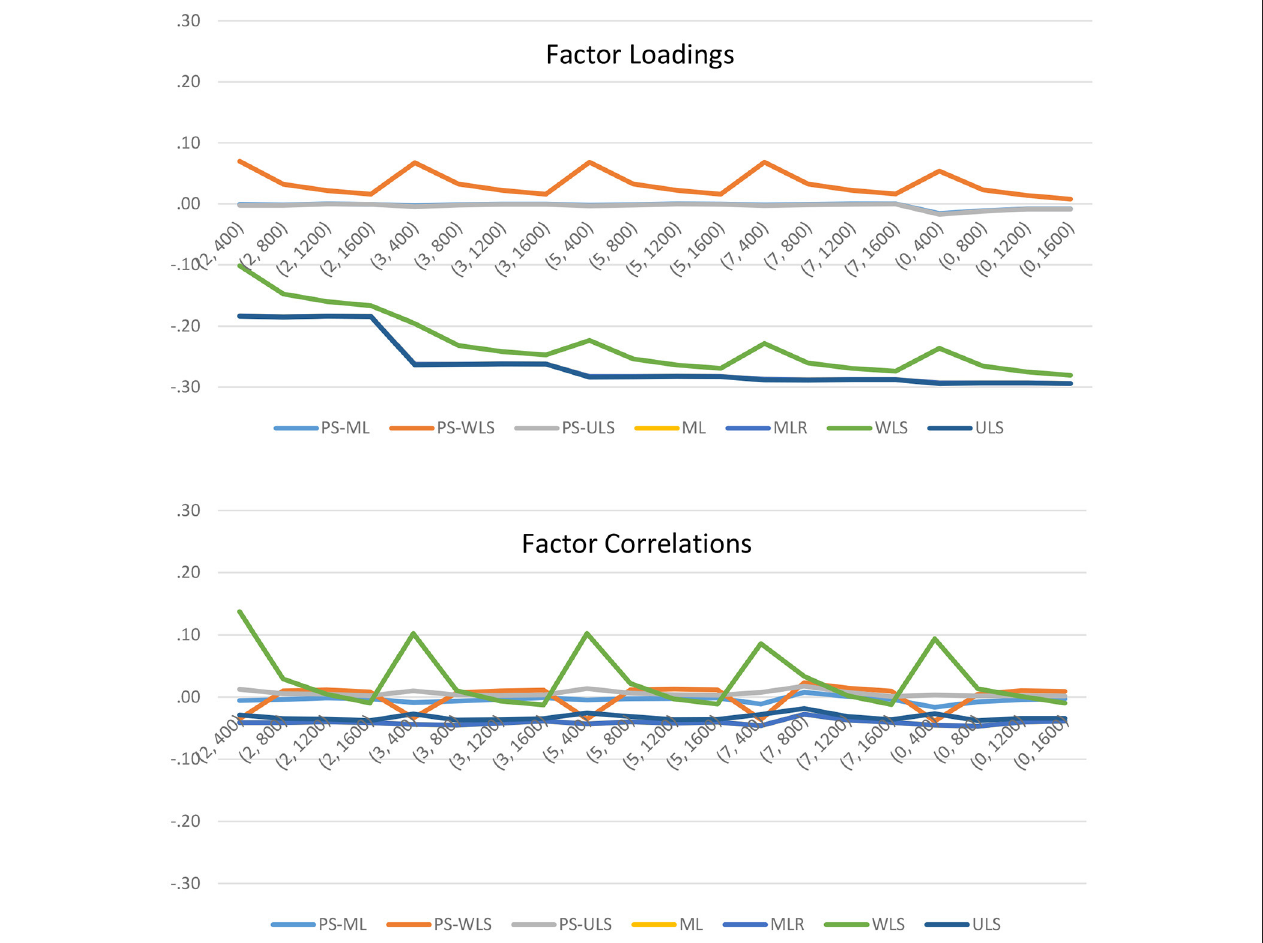
FIGURE 4 | Biases of the factor loadings and factor correlations when data are PS-related. The horizontal axis shows the 20 simulation conditions, where the first number of the bracket indicates the scale of measurement (i.e., 2 number refers to the sample